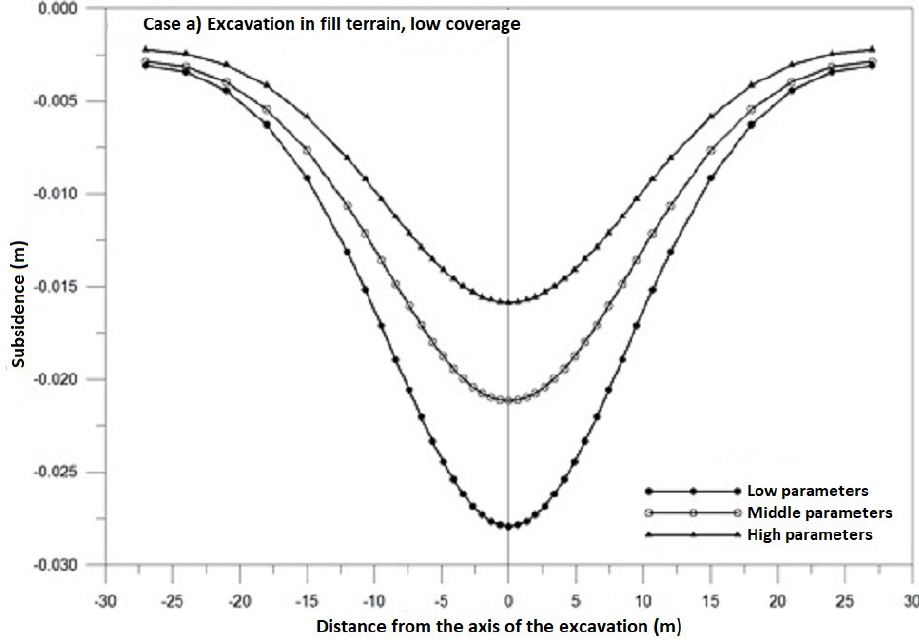
Figure 16. Settlements on the ground surface for excavation in landfills with little coverage (8